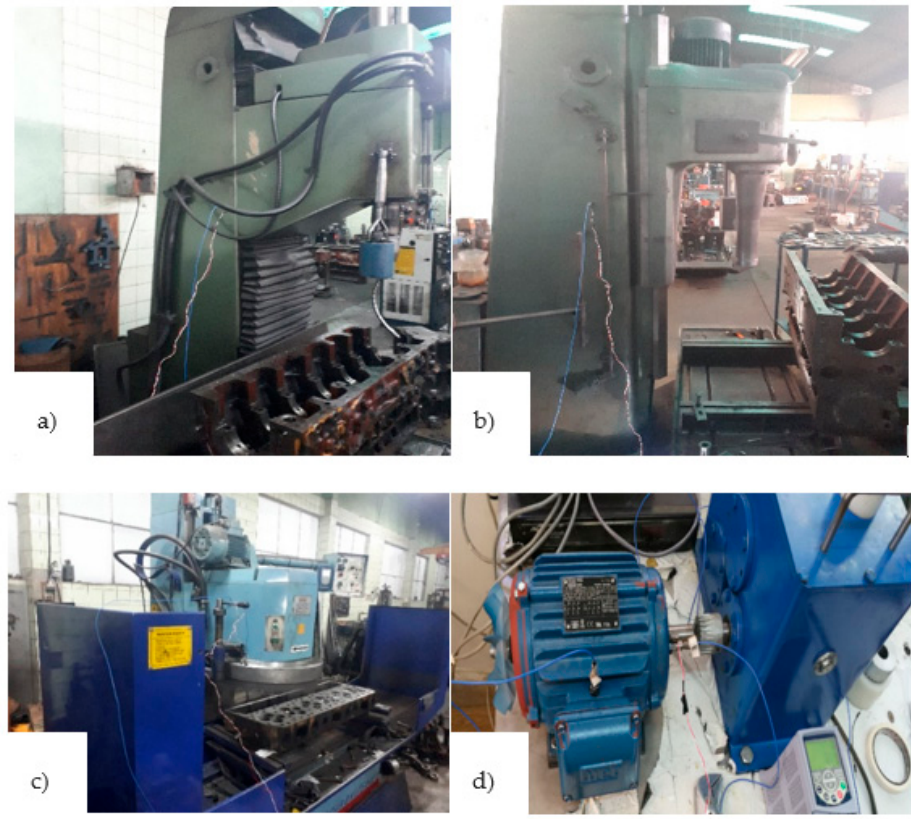
Figure 5. Measurements performed on four types of machines: ( a ) honing machine, ( b ) cylinder rectifier, ( c ) surface rectifier, and ( d ) induction motor.